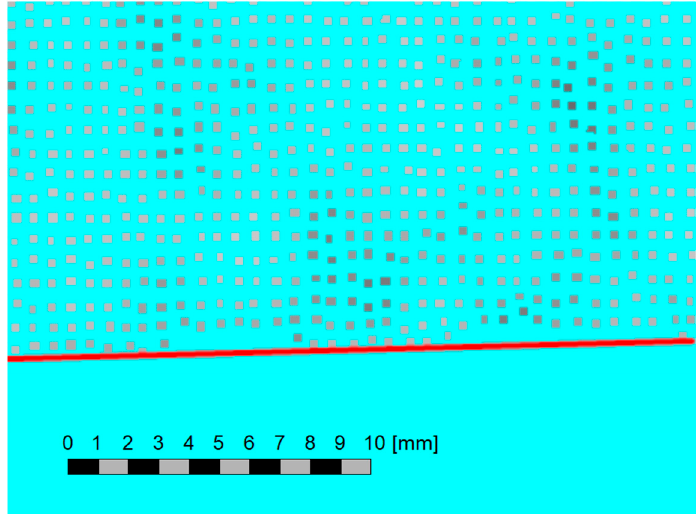
Figure 15. Cloud of points on the edge of the element.